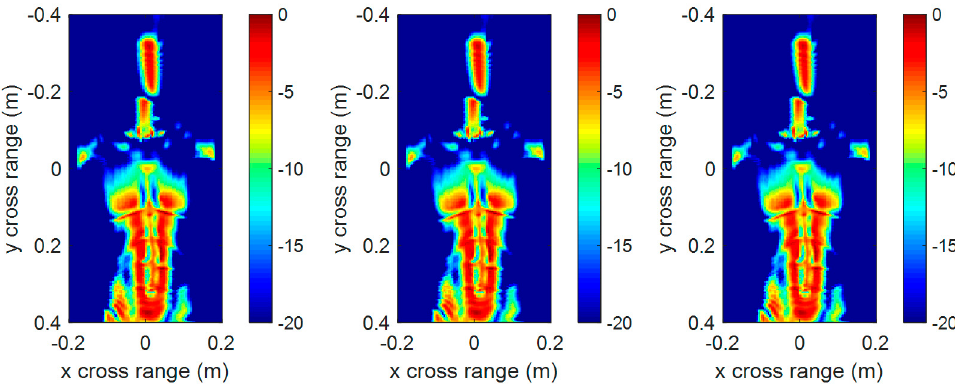
Figure 11. The front view of 3-D imaging results by conventional RMA with compensation distance 0 ( left ), 0.43 m ( middle ), and 0.86 m ( right ).